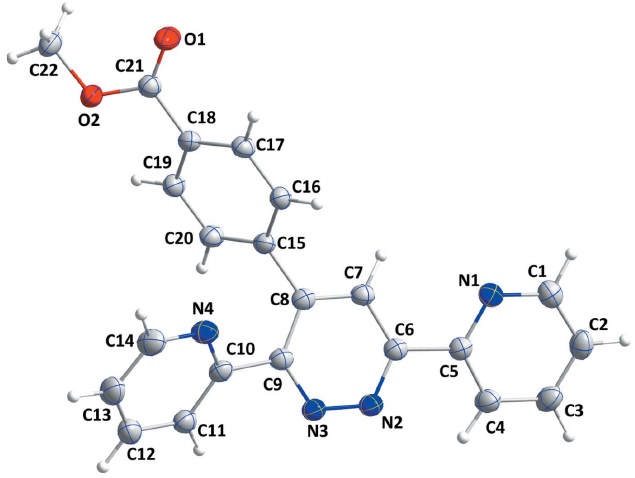
Figure 3 View of the three-dimensional Hirshfeld surface of the title compound plotted over d norm in the range (cid:3) 0.1417 to 1.3796 a.u.